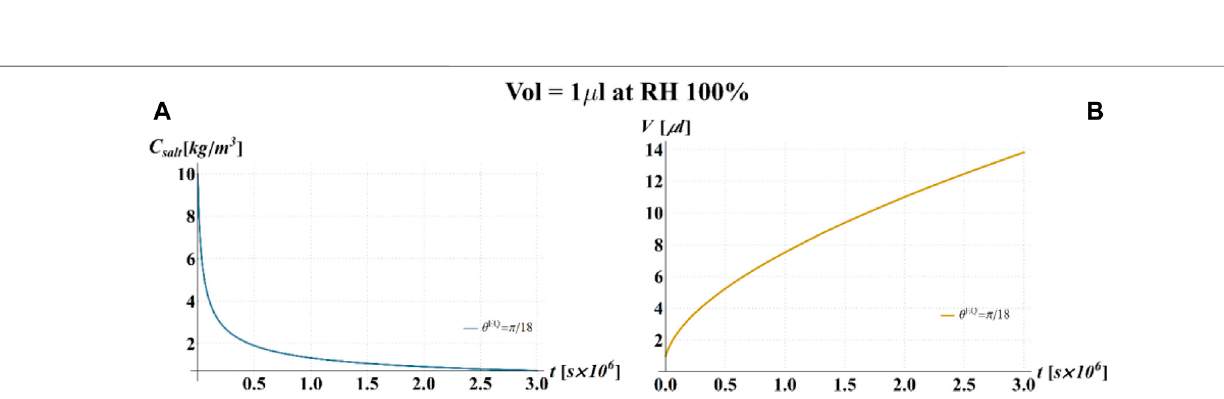
Frontiers in Materials |